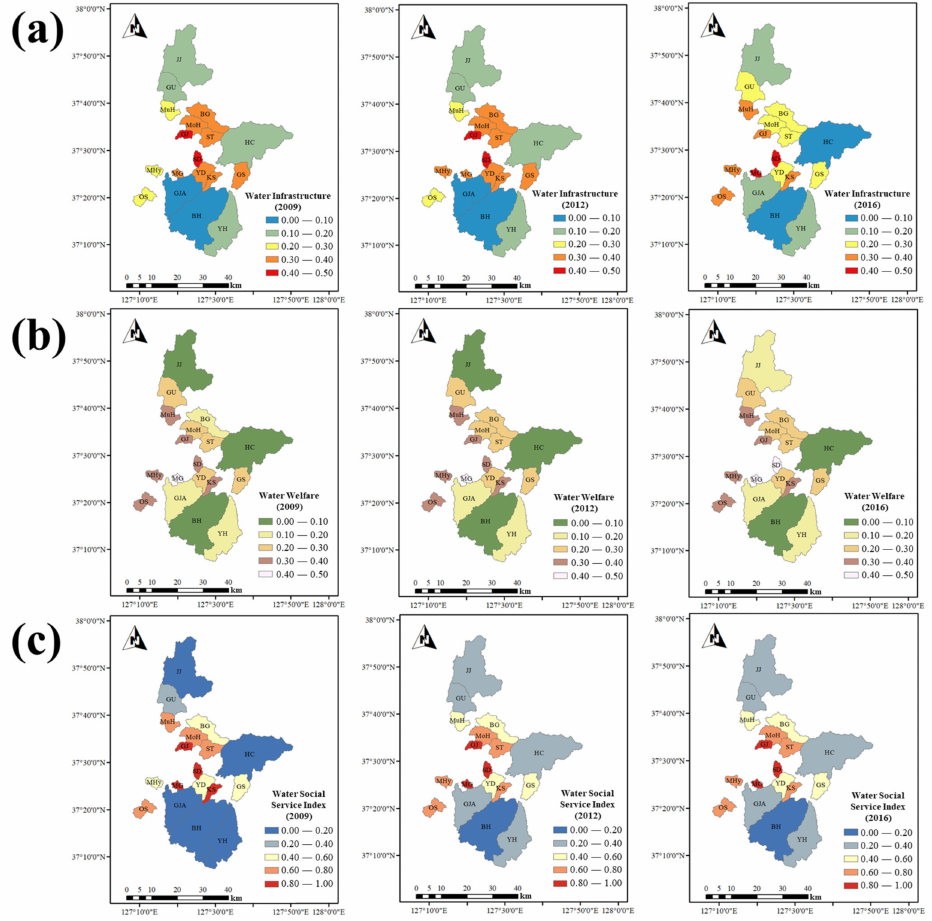
Figure 5. Spatial variation of the detailed indicators during the study period: ( a ) Water Infrastructure; ( b ) Water Welfare; ( c ) Water Social Service